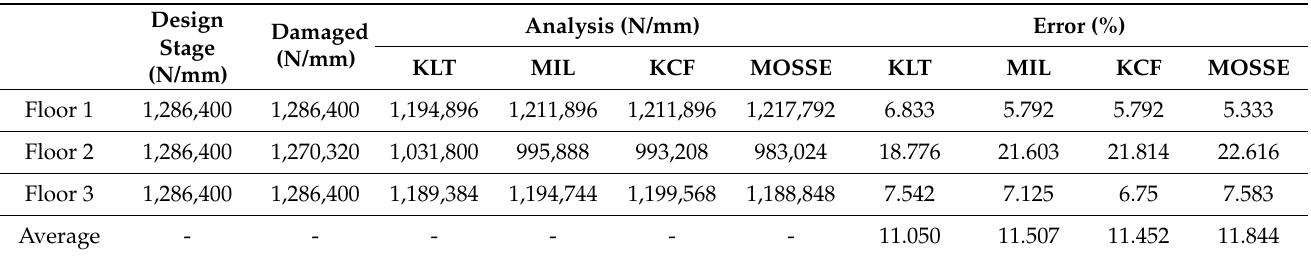
Table 3. Comparison of column stiffness between experiment and prediction model using different tracking algorithms.